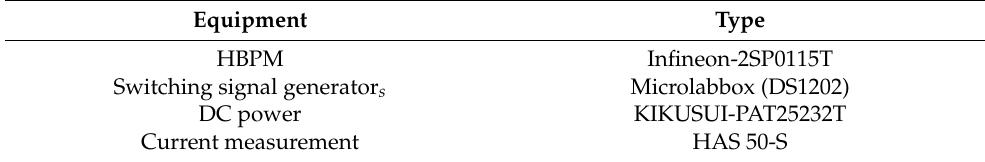
Table 2. Experimental